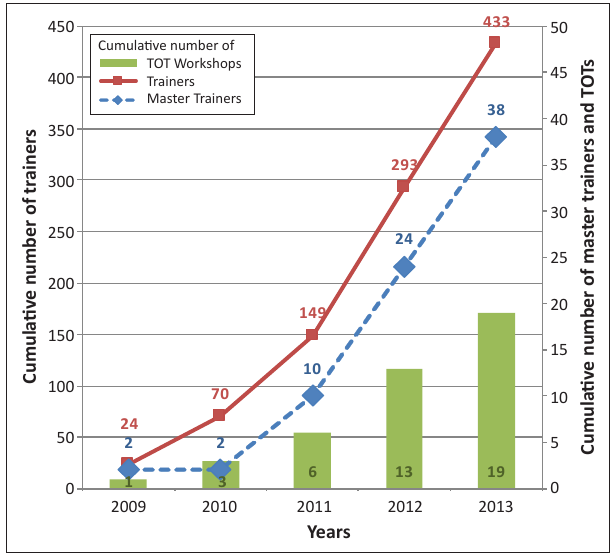
FIGURE 1 : Cumulative number of SLMTA trainers, master trainers and TOTs 2009–2013.